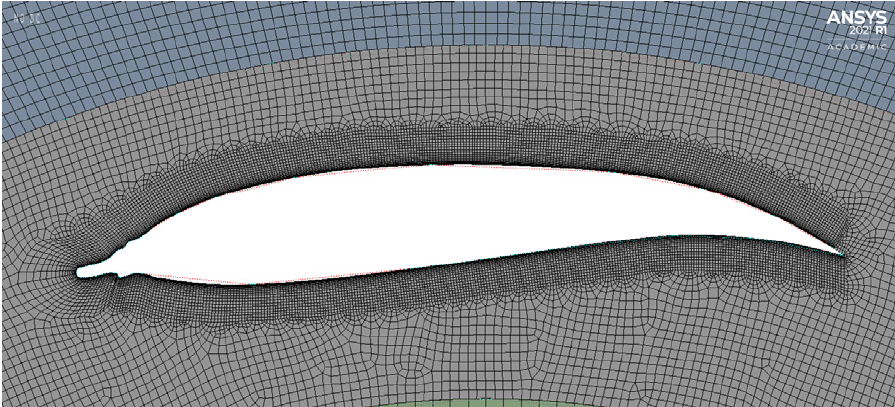
Figure 6. Mesh around the 5-h severe rime ice blade.